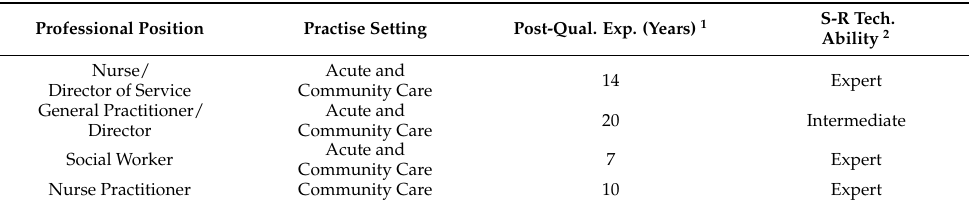
Table 2. Demographics and characteristics of healthcare professionals (HCPs) as subject-matter (content) ‘expert’ evaluators assessing the CarerHelp Toolkit prototype.